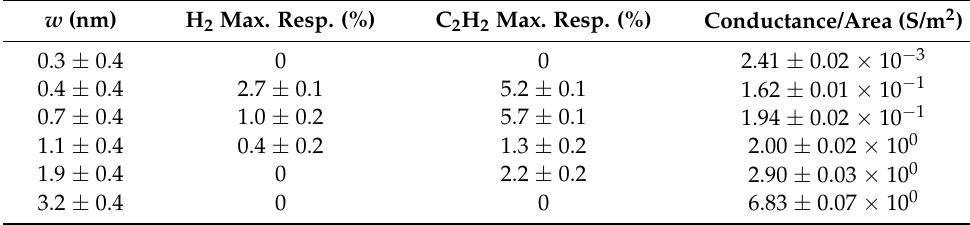
Table 2. Maximum resistive response measuring under exposure to 5% of H 2 and C 2 H 2 concentration in Ar atmosphere for several LC-CNTs devices.